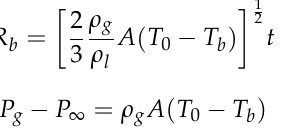
here, R b denotes the radius of bubble (m). ρ l and ρ g denote the density of liquid and vapor respectively (kg/m 3 ). A is a linearization constant. T 0 is the initial temperature at the bubble boundary and T b is the saturation temperature of the liquid (K). P g and P ∞ denote the vapor pressure inside bubble and the ambient pressure.